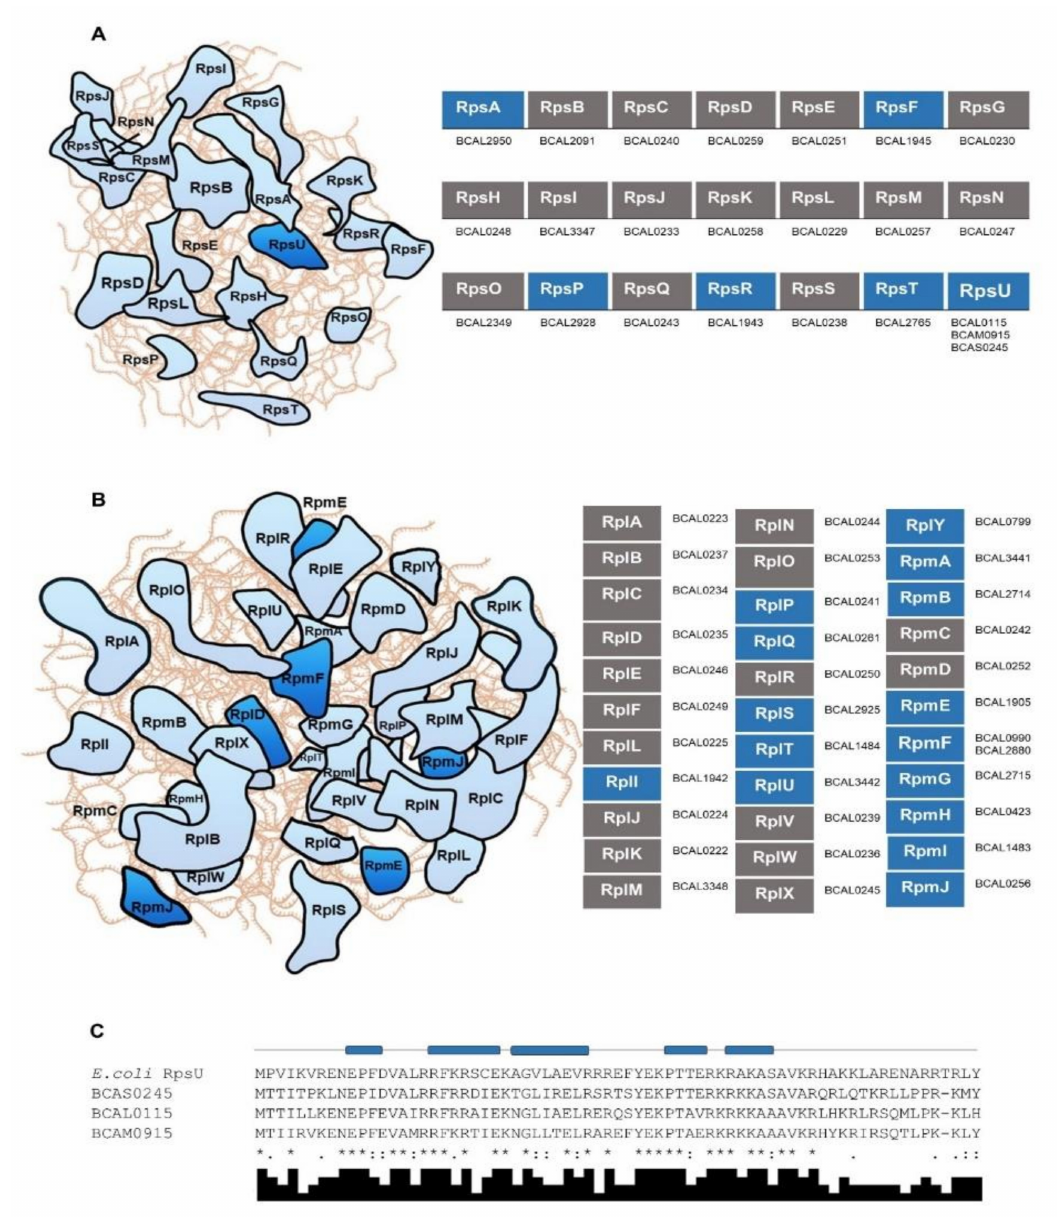
Figure 1. Burkholderia cenocepacia J2315 ribosomal proteins that compose the 30S ( A ) and the 50S ( B ) subunits of the bacterial ribosome described for Escherichia coli . Panels A and B, left part: schematic representation of the ribosomal RNA (light brown lines) and the r-proteins colored in light blue (one copy gene) or dark blue (at least two paralogs genes in E. coli or B. cenocepacia J2315). Right part: loci tags of each B. cenocepacia J2315 ortholog are mentioned. Rectangles colored in blue represent r-proteins only encoded in bacterial genomes, and grey rectangles represent universal r-proteins that can be found in all domains of life. ( C ) Alignment of the amino acid sequences of the small subunit protein S21 (RpsU)-like proteins from B. cenocepacia J2315 (BCAL0115, BCAM0915, and BCAS0245) and E. coli (b3065). Asterisks (*) indicate identical amino acid residues, one (.) or two dots (:) indicate semi-conserved or conserved substitutions, respectively. The predicted secondary structure of E. coli RpsU protein is shown above the alignment segment, where cylinders represent α -helices. Alignments and secondary structure predictions were performed with MUSCLE [41] and PSIPRED [43] software,